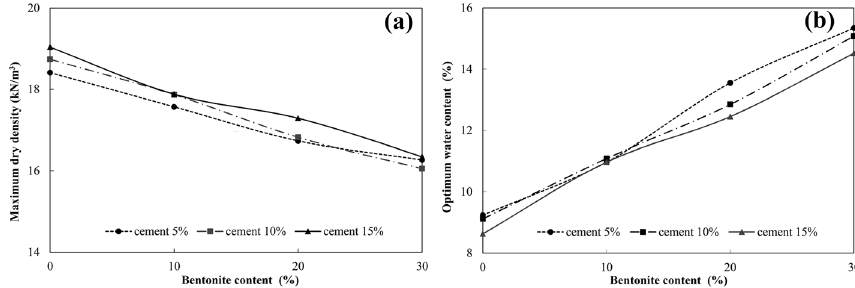
Fig. 5 The graph of maximum dry density and optimum water content for the CSG mixtures containing bentonite additive